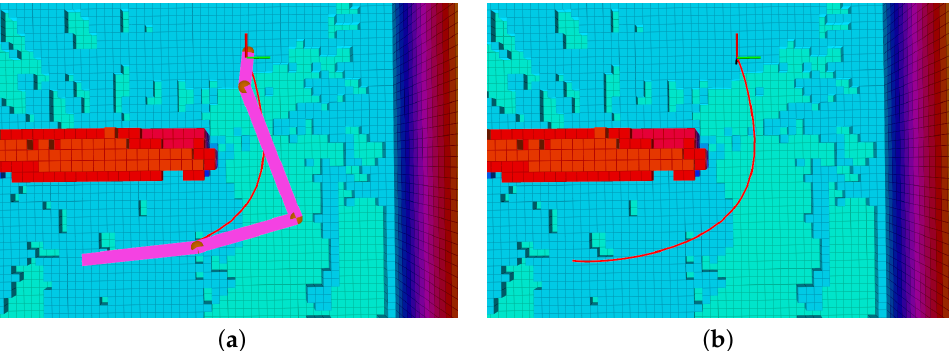
Figure 10. Motion Planner. ( a ) Path planning using graph-based approach (pink) and NMPH algorithm (red). ( b ) Optimal path using NMPH